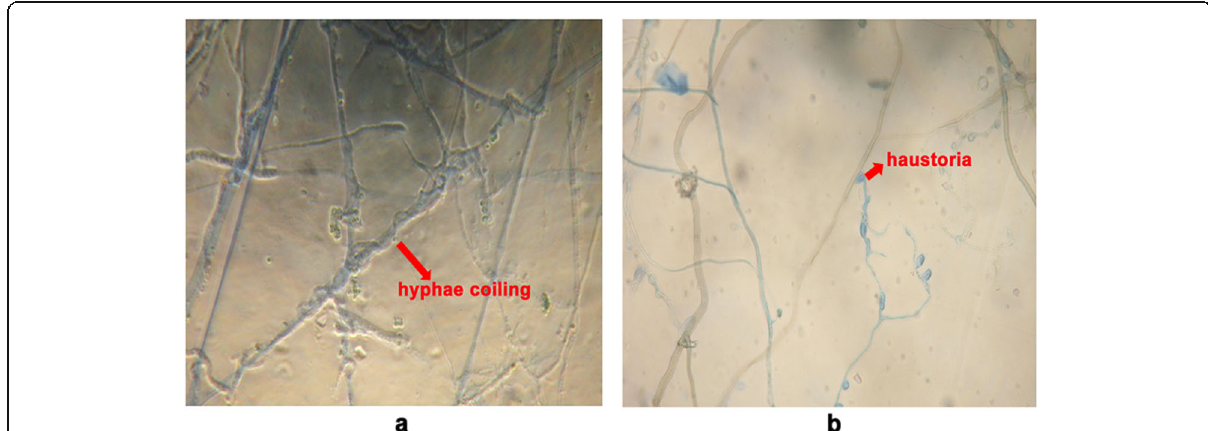
Fig. 2 Mycoparasitism by Trichoderma hyphae a coiling around the hyphae of Rhizoctonia solani and b producing haustoria to inhibit growth of Macrophomina